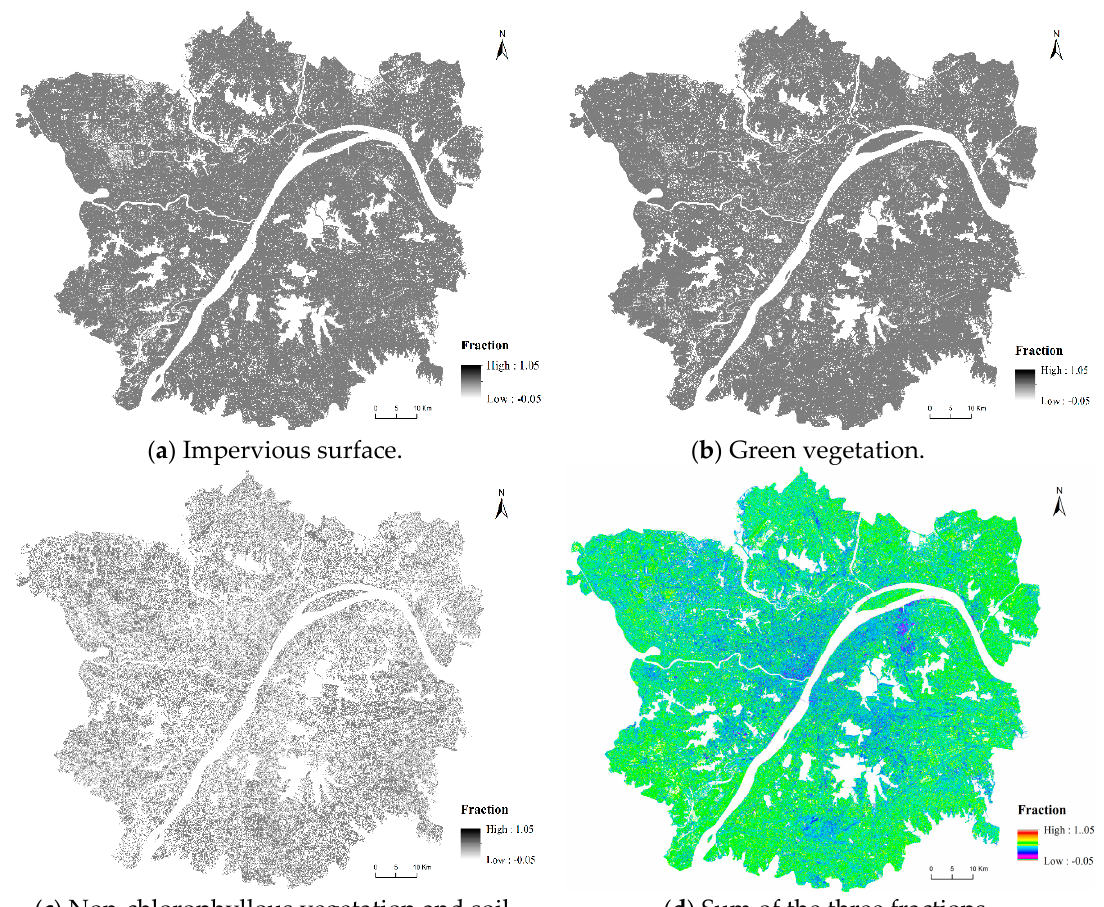
Figure 3. The land cover fraction (LCF) maps of 2014.